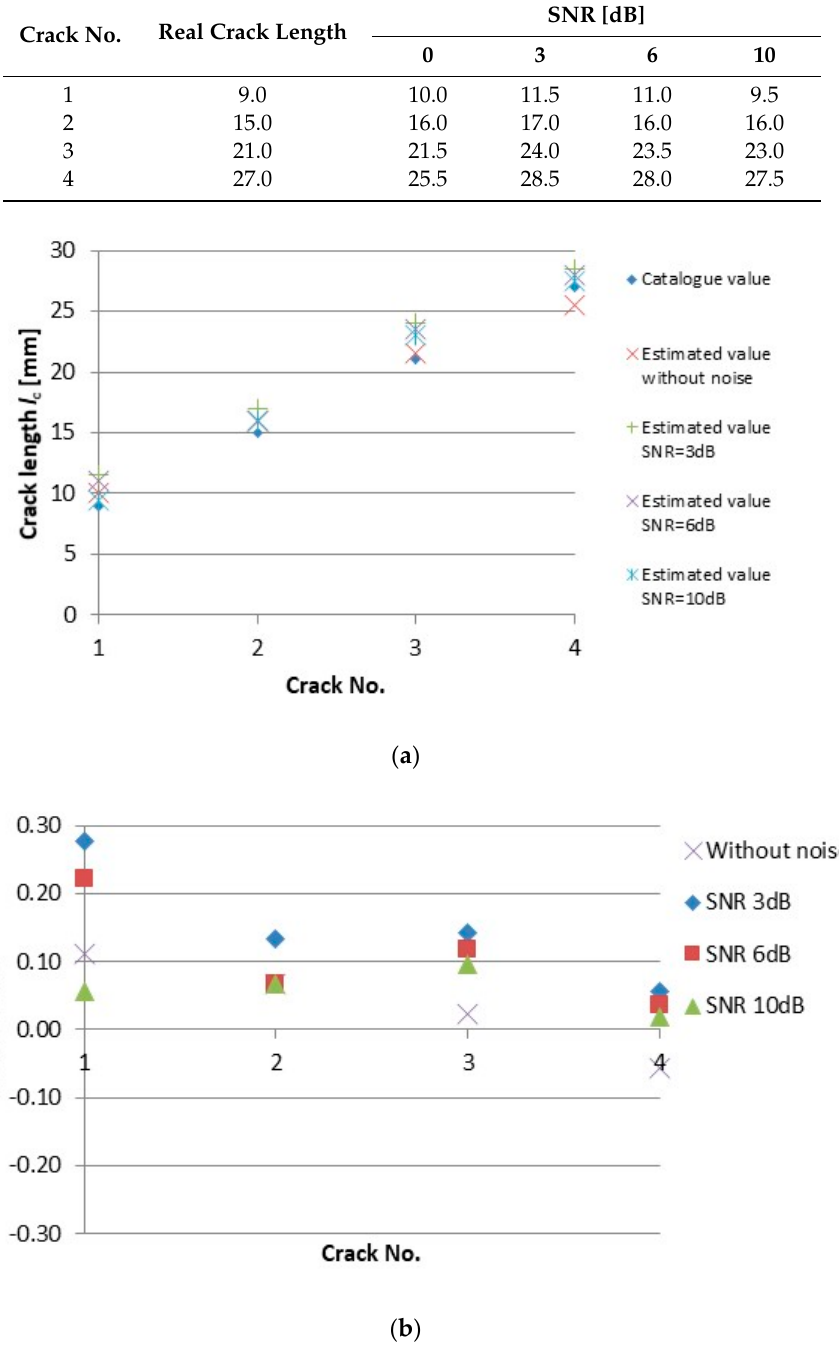
Table 2. Values of the reconstructed crack length l c [mm] from the ECT responses with di ff erent Signal to Noise Ratio (SNR).